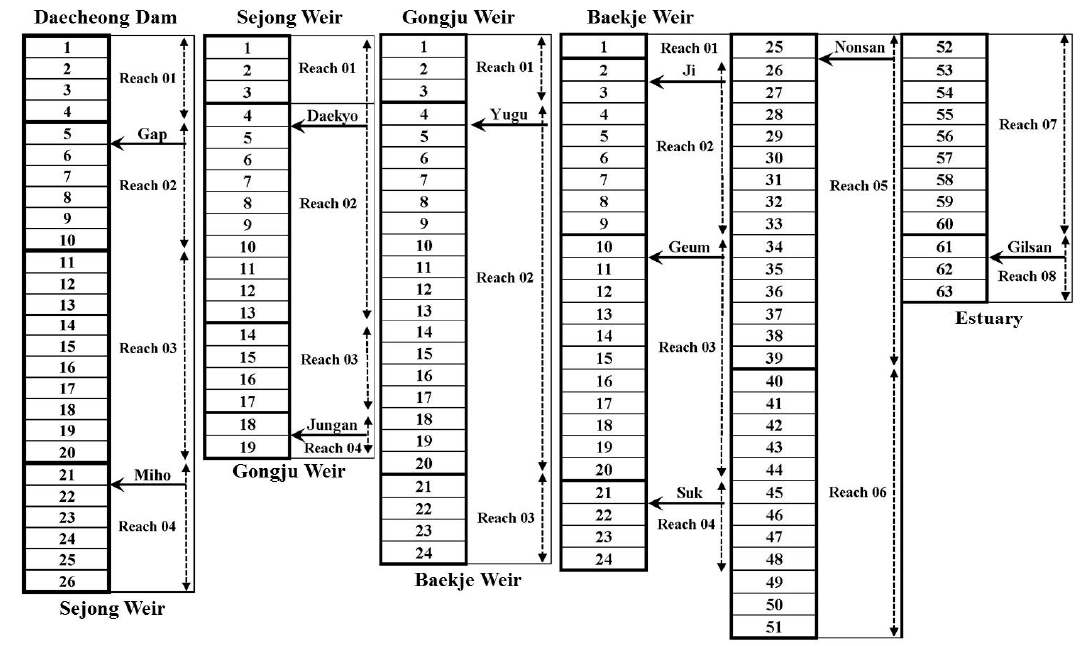
Figure 9. Flowchart of the water quality model.